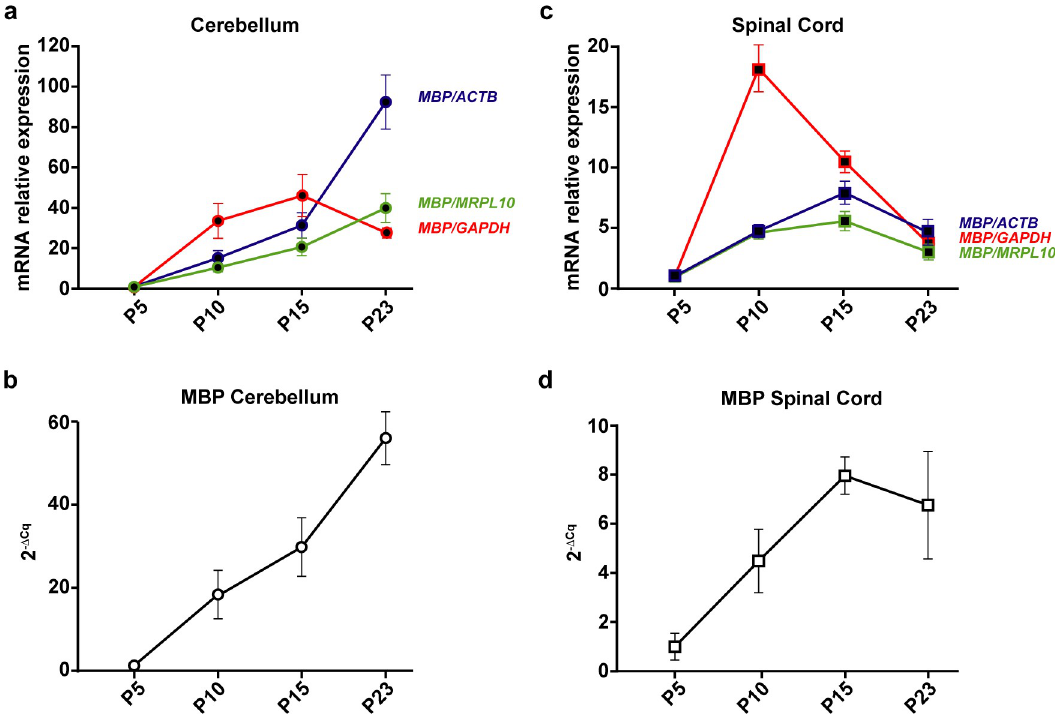
Fig 1. Mbp mRNA levels at post-natal day (P)5, 10, 15 and 23 in the cerebellum and spinal cord. P5 group is the experimental calibrator. (a) Cerebellar Mbp mRNA levels normalized using either Actb, Mrpl10 or Gapdh mRNA quantities. (b) Un-normalized profile of cerebellar Mbp expressed as a fold change of mRNA quantities across groups (2 - Δ Cq ). (c) Spinal cord Mbp mRNA levels normalized using either Actb, Mrpl10 or Gapdh mRNA quantities. (d) Un-normalised profile of spinal cord Mbp expressed as a fold change of mRNA quantities across groups (2 - Δ Cq ). Results are expressed as the Mean ± SD for each time